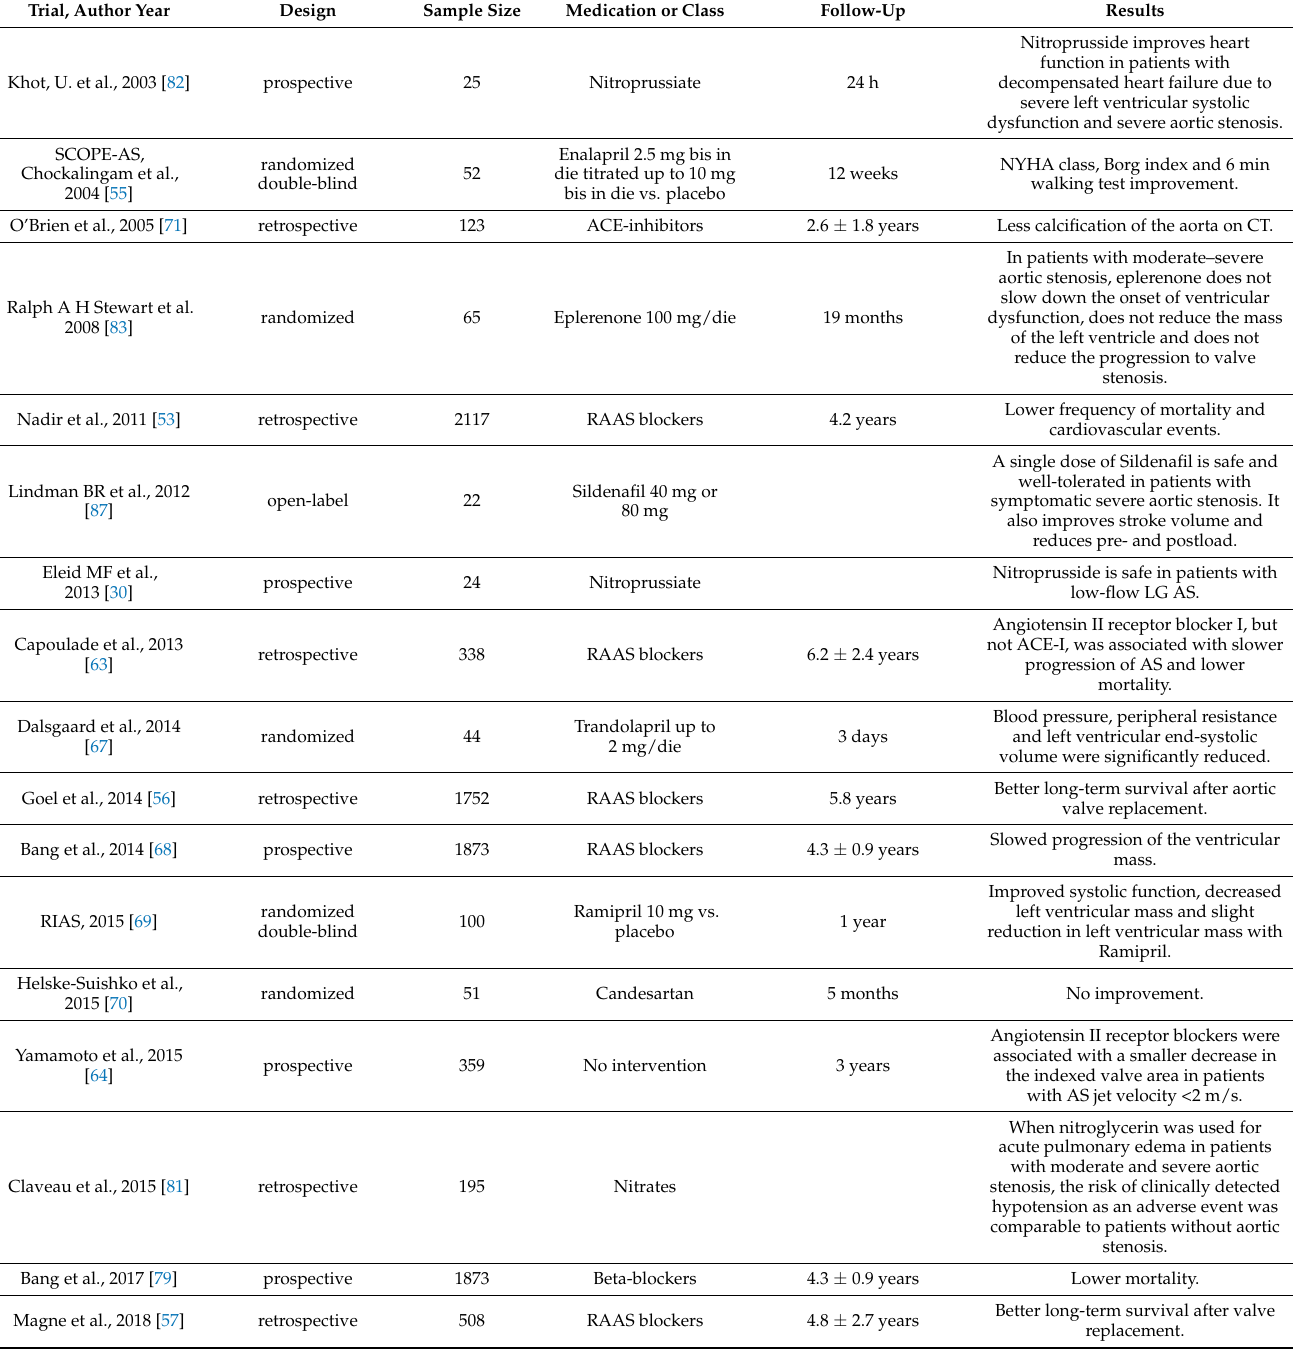
Table 1. Selected studies on the treatment of hypertension in aortic